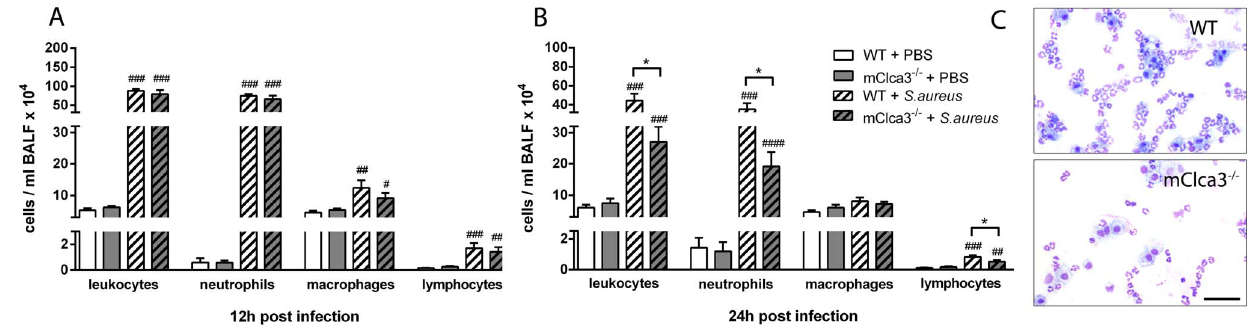
Figure 3. Pulmonary neutrophils and lymphocytes were significantly decreased in mCLCA3-deficient mice 24 hours after infection. (A, B) At 12 hours and 24 hours after infection, leukocytes in bronchoalveolar lavage fluid (BALF) were manually counted and subpopulations were analyzed by fluorescence-activated cell sorter (FACS). Values are given as mean 6 SEM (n=8 each group). # p , 0.05, ## p , 0.01, ### p , 0.001, #### p , 0.0001 versus PBS controls. *p , 0.05 as indicated. (C) Cytospins from BALF 24 hours post infection were obtained by centrifugation and BALF cell suspension was subsequently stained with May-Gru¨nwald Giemsa. Leukocyte numbers were reduced in BALF from mClca3 2 / 2 mice (n=8 each group). Bar, 50 m m.